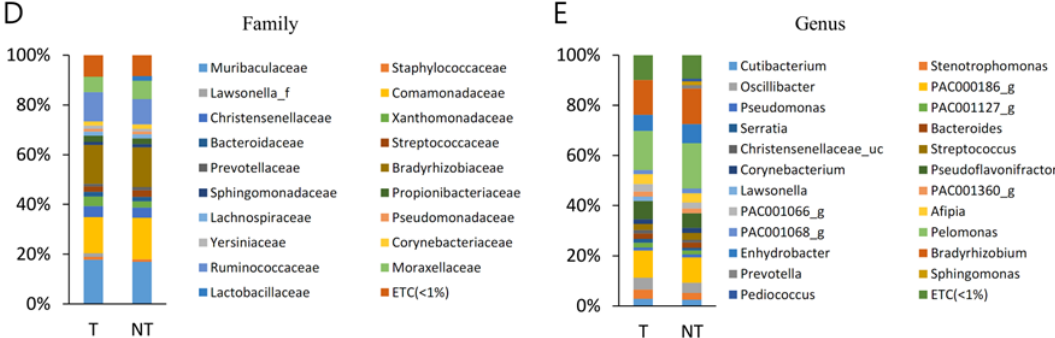
Figure 1. Averaged taxonomic composition in malignant prostate cancer tissues (MT) and peri-malignant prostate cancer benign prostatic tissues (BT) of prostate cancer patients. Taxonomic relative abundance was classified at the ( A ) phylum, ( B ) class, ( C ) order, ( D ) family, and ( E ) genus levels, and relative abundances less than 1% were expressed as ETC. The Wilcoxon signed-rank test was used to analyse the significance between the two. Across all ranks, none of the taxa with a relative abundance greater than 1% showed a significant difference.